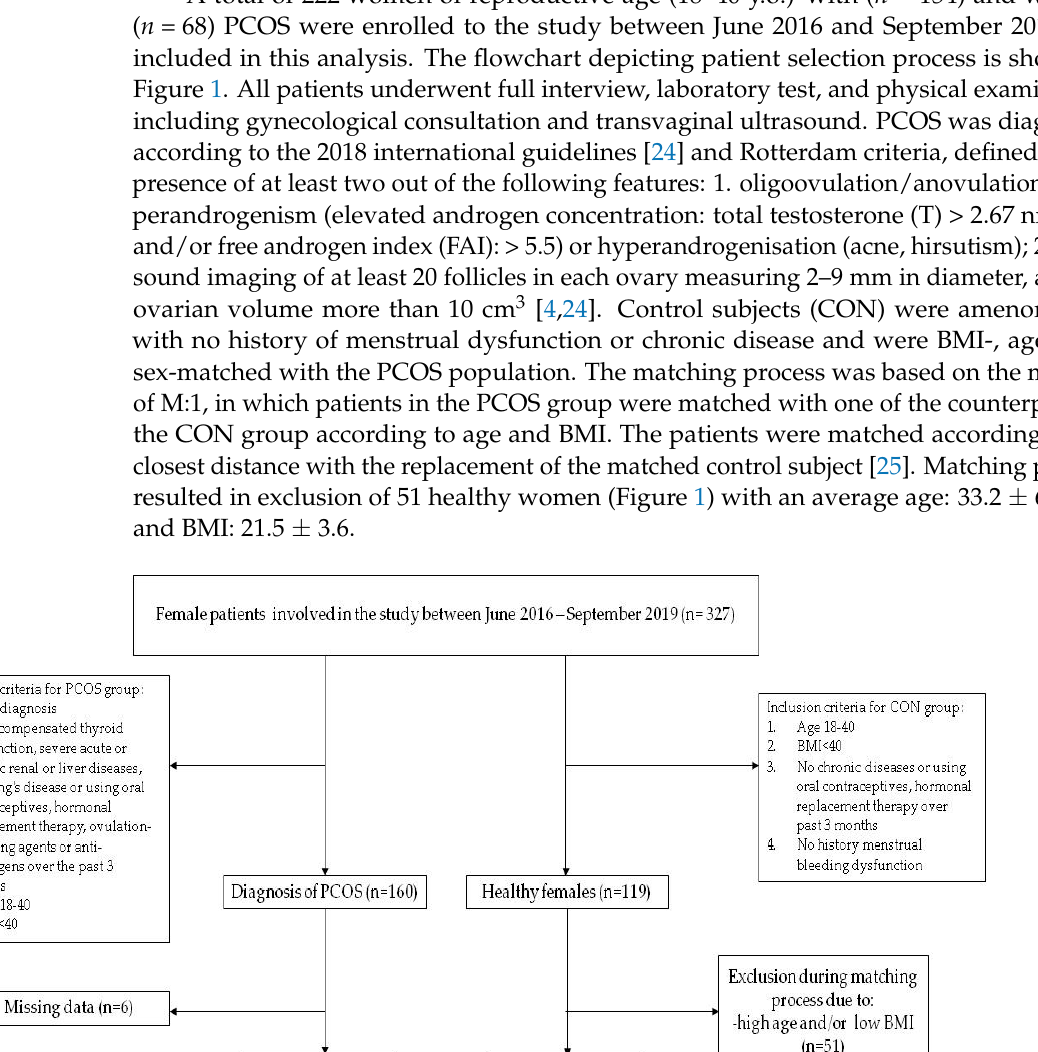
Figure 1. Study participant selection process.